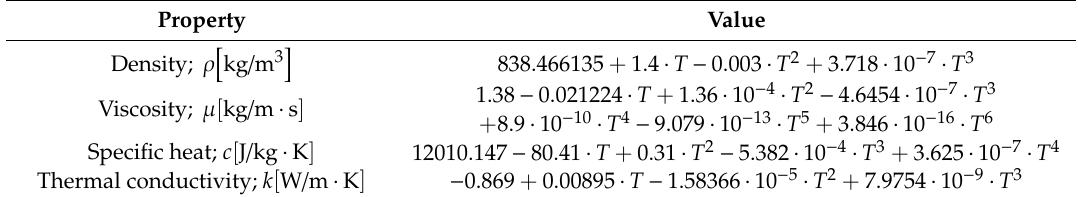
Table 1. Thermo-physical properties of water [33].